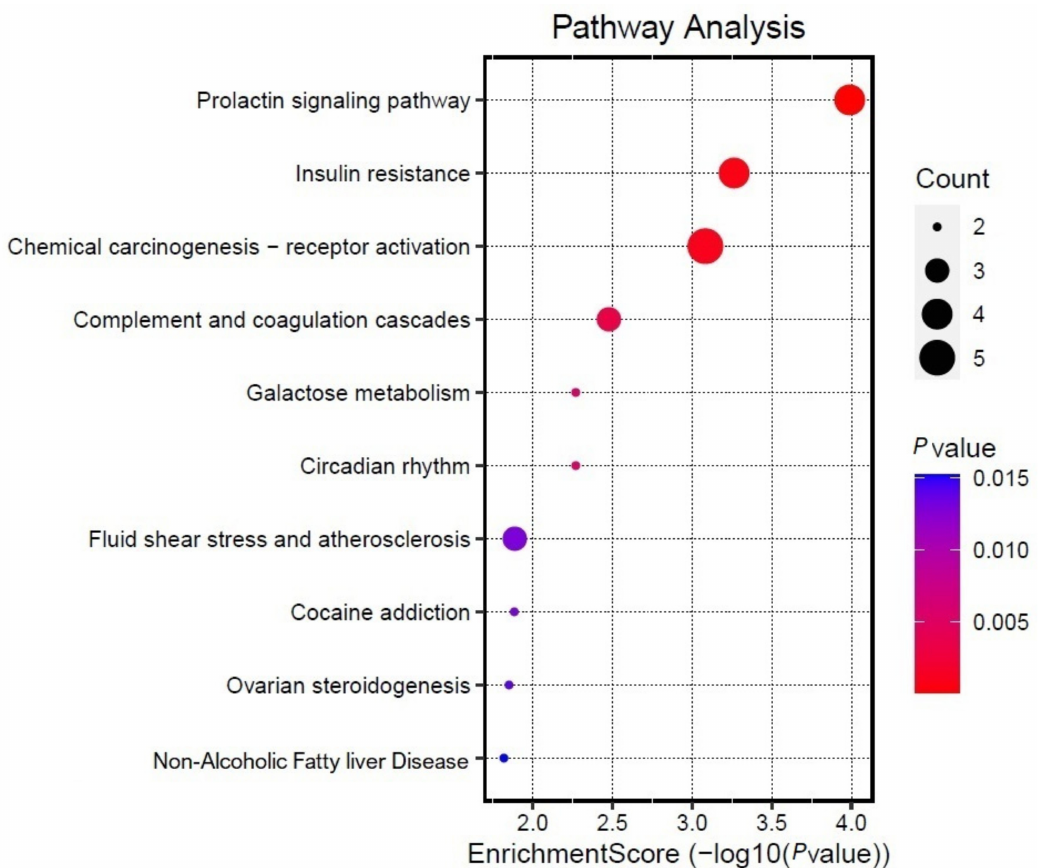
Figure 4. KEGG enrichment analysis of target genes.